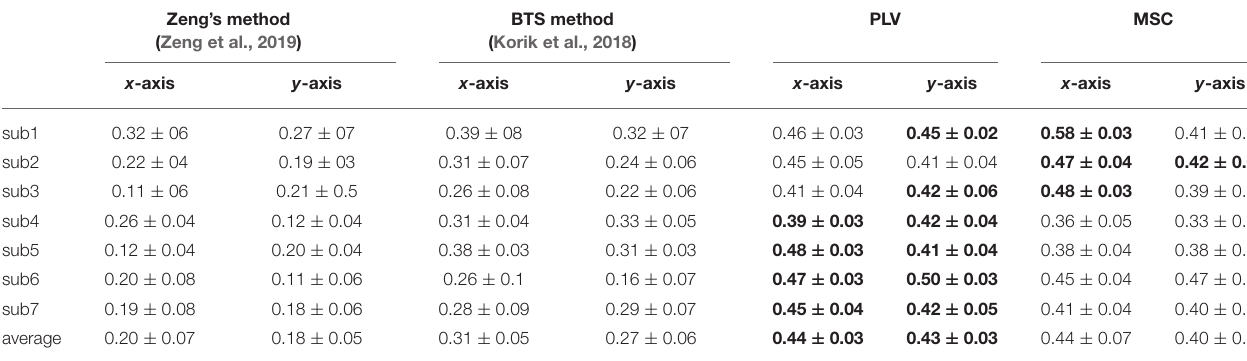
TABLE 1 | Comparing reconstruction performance of the proposed method to Zeng’s and BTS methods. Zeng’s method (Zeng et al., 2019)